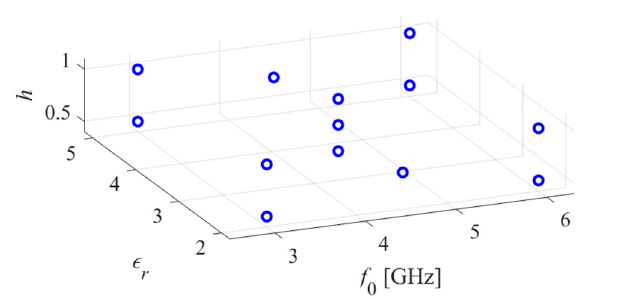
Figure 11. Broadband patch antenna [56]: ( a ) geometry (ground plane shown using light gray shade), ( b ) 3D views.